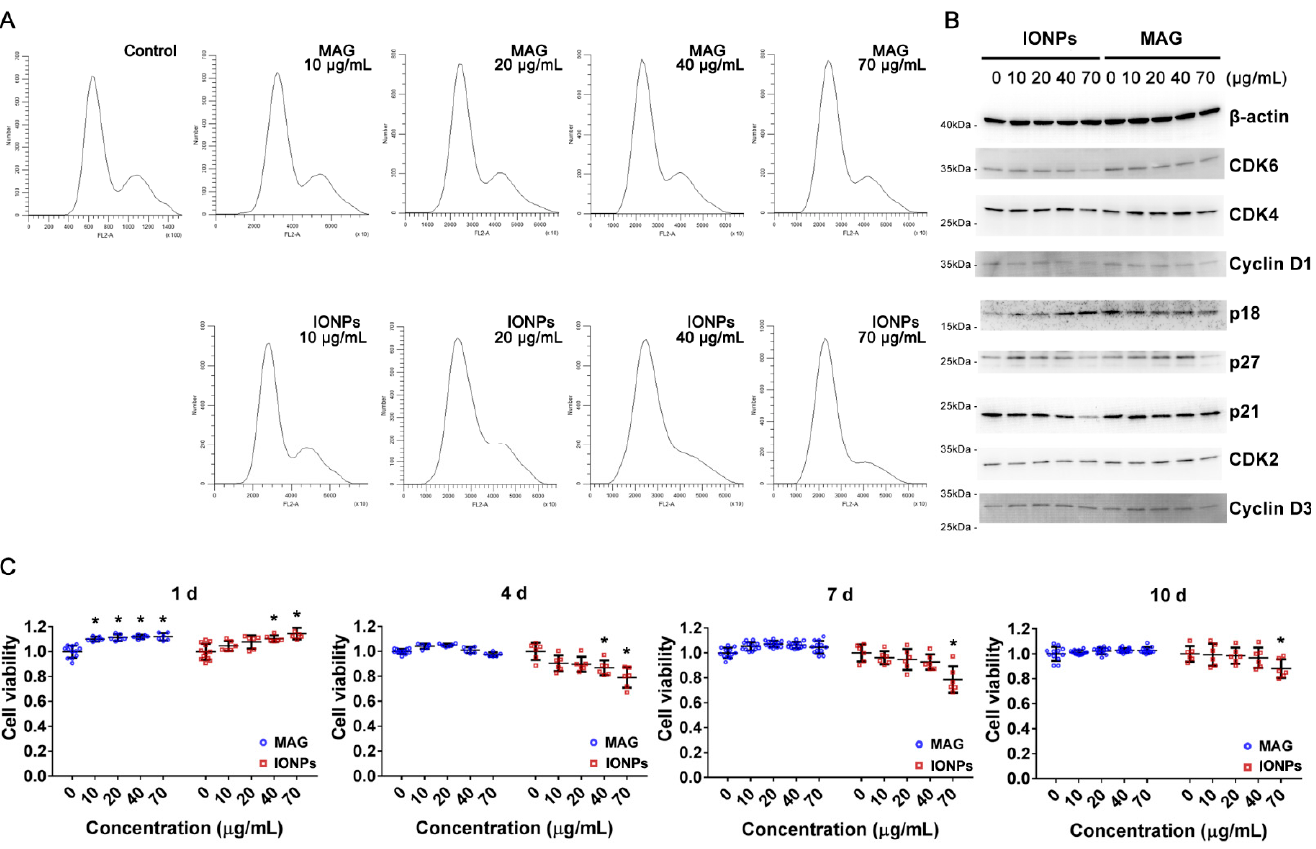
Figure 2. Analysis of cell cycle and cell viability of endothelial cells (ECs) treated with or without nanoparticles. ( A ) Cell-cycle distribution of ECs after exposure to MAGs or IONPs for 48 h over a dose range of 10-70 µ g Fe/mL. Control, ECs without nanoparticle treatment. ( B ) The expressions of proteins that are essential for cell-cycle progression in ECs treated with MAGs or IONPs for 48 h over a dose range of 0-70 µ g Fe/mL. β -actin, loading control; CDK, cyclin-dependent kinase. ( C ) ECs viability analysis in the presence of MAGs or IONPs or not. The treated samples were normalized to control cells (treated with 0 µ g Fe/mL particles) for each timepoint, respectively, and the viability of control cells was regarded as 1.0 (n ≥ 6, data are shown as mean ± SD; * p -value < 0.05; d, day).